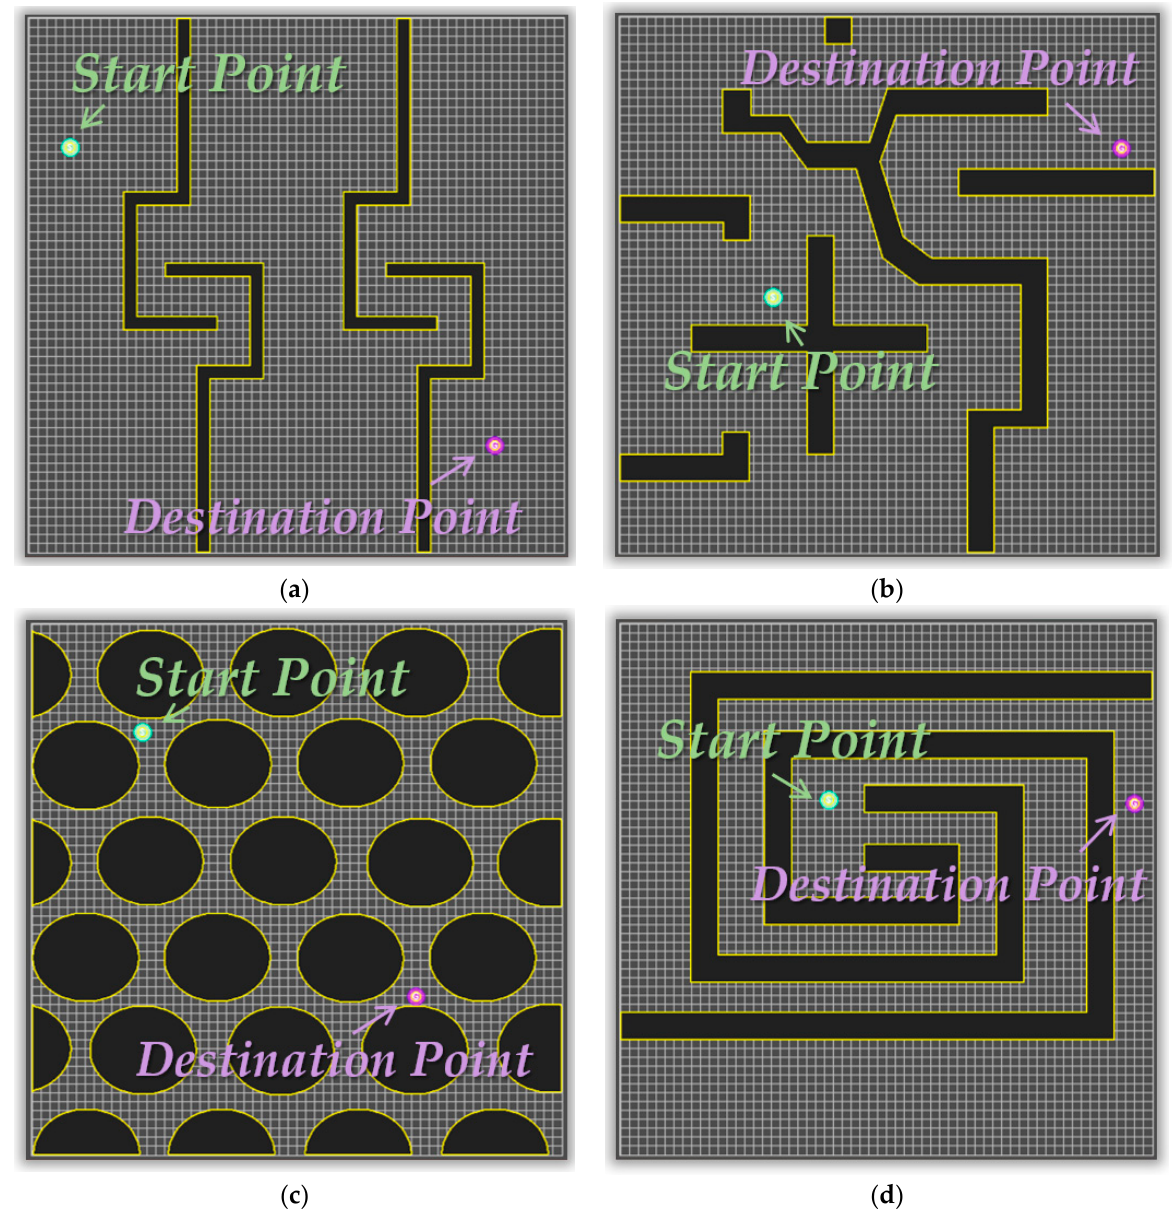
Figure 8. Environment maps for experiments: ( a ) Map 1; ( b ) Map 2; ( c ) Map 3; ( d ) Map 4.